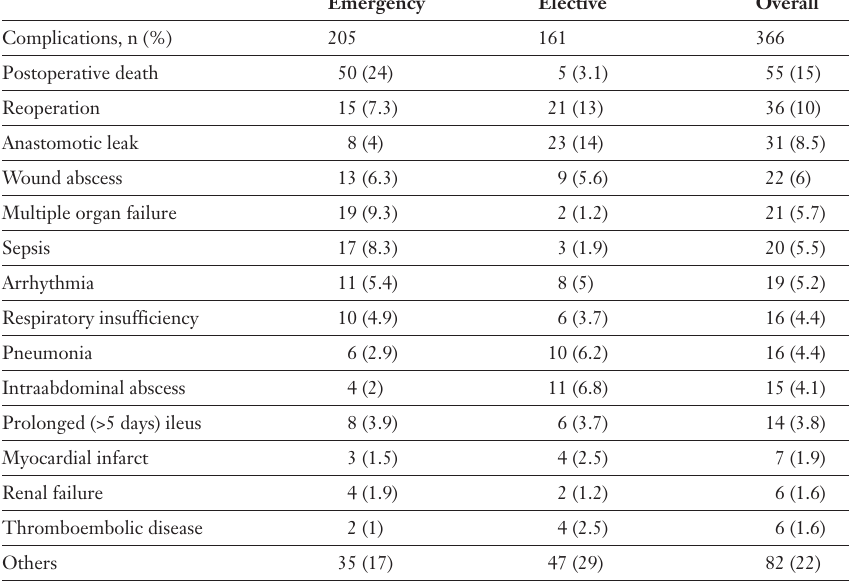
Complications of surgery.